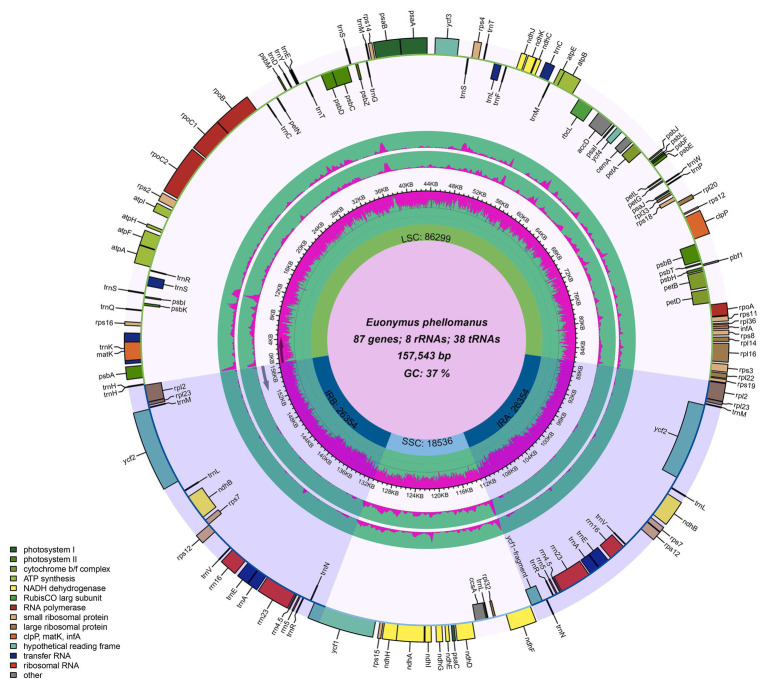
Chloroplast genome maps of Euonymus species. The species name and specific information regarding the genome (length, GC content, and the number of genes) are depicted in the center of the plot. Extending outward, the middle two layers are the nucleotide diversity of E.fortunei (inner) and E. maackii (Outer) compared with E. phellomanus, respectively.